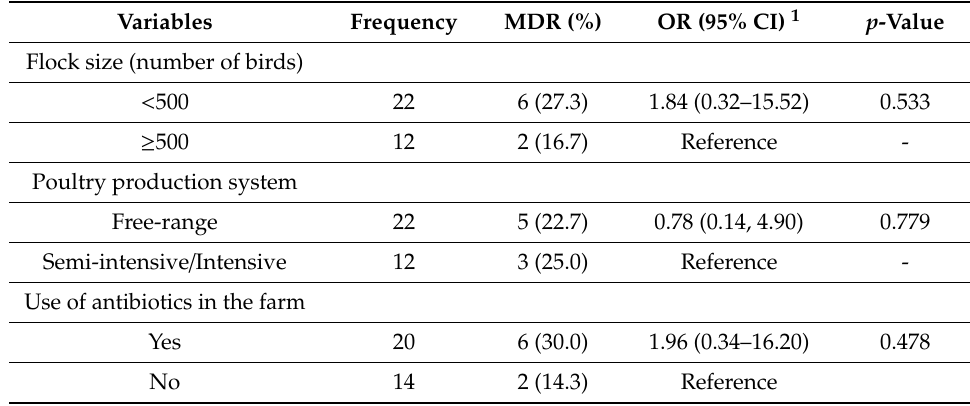
Table 4. Risk factors associated with the occurrence of MDR Salmonella amongst village chickens from the South-central Peninsular